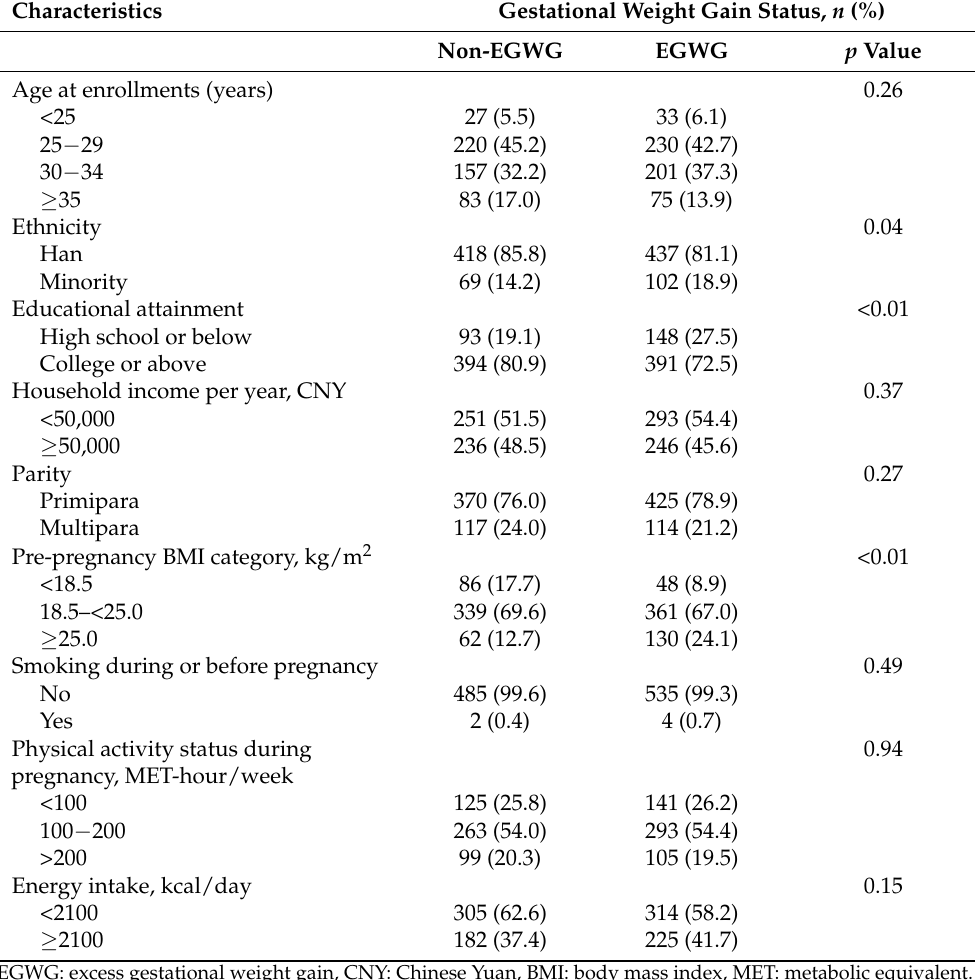
Table 1. Maternal characteristics by gestational weight gain status ( n =